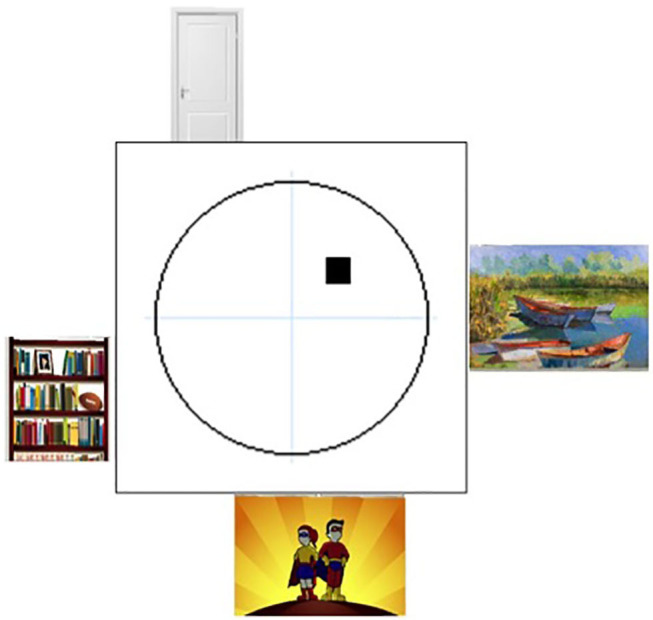
The environment of the Virtual Morris Water Task. Overview of the virtual environment used in the Virtual Morris Water Task, with on each wall a different visual cue. The platform is indicated by the black square in the northeast quadrant of the pool.